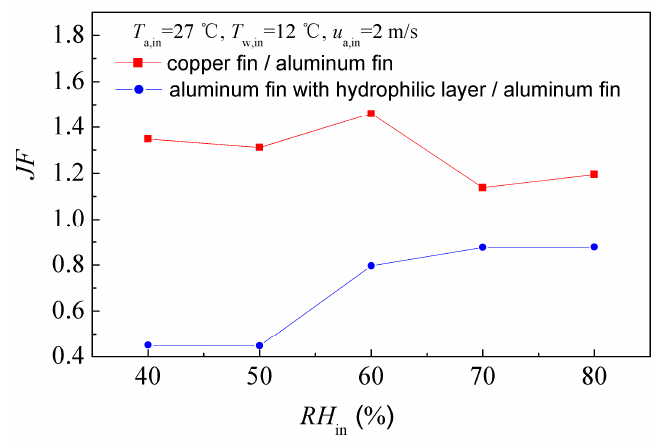
Figure 14. Effect of RH in on JF .